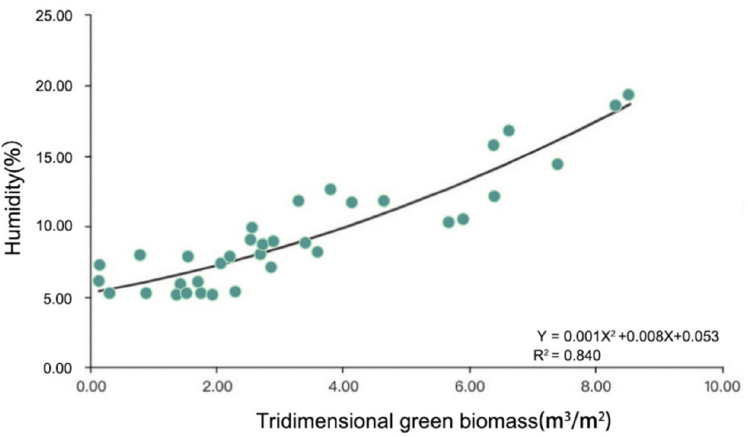
Figure 6. Relationship between humidification and tridimensional green biomass.